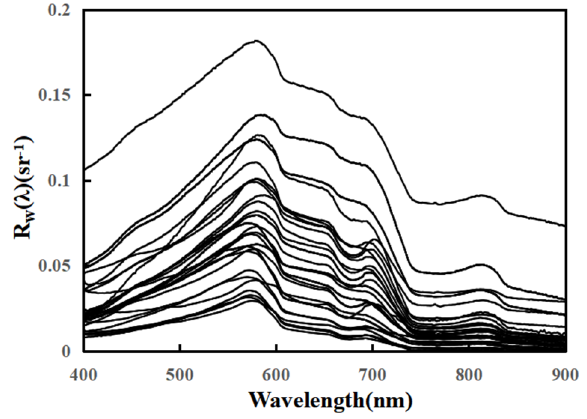
Figure 2. Reflectance measured at the study sites.